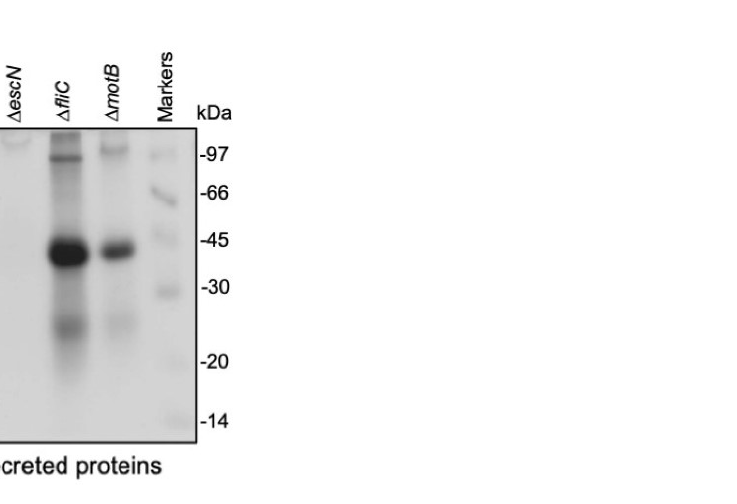
Figure 7. Analysis of T3 secreted proteins in wild type E2348/69 and derivative mutants. Filtered and concentrated supernatants from bacteria grown in DMEM were electrophoresed in 14% SDS–PAGE gels. The ∆ escN mutant (unable to assemble a T3SS and secrete proteins) was used as negative control.